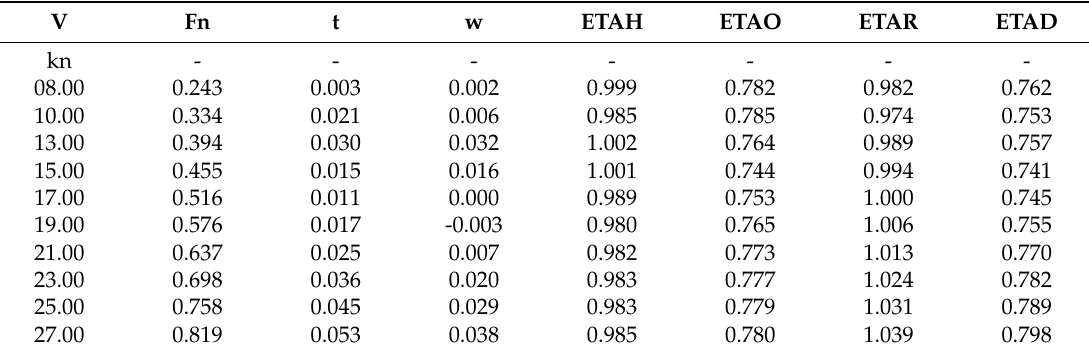
Table 3. Experimentally measured hull and propulsive e ffi ciencies for the design displacement of the Stavanger demonstrator (full scale). V: speed in knots; Fn: Froude number; t: thrust deduction fraction;